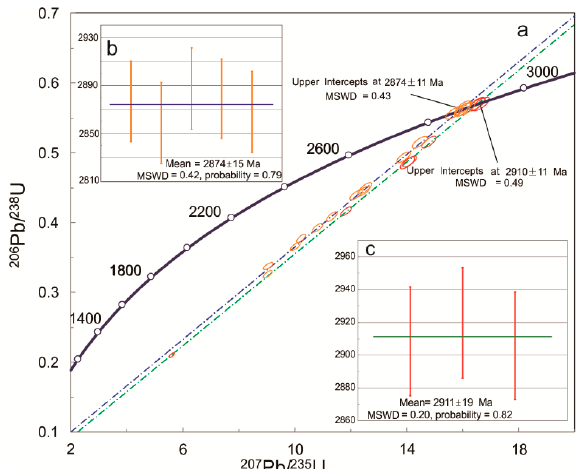
Figure 13. Zircon U–Pb concordia age diagrams for the moyite dike (D0002-5). ( a ) Diagram for all analyzed spots that gave two discordia lines with two upper intercept 207 Pb/ 206 Pb ages of 2910 ± 11 Ma and 2874 ± 11 Ma; ( b ) Diagram for five concordant analyses that gave a weighted mean 207 Pb/ 206 Pb age of 2874 ± 15 Ma; ( c ) Diagram for three concordant analyses that gave a weighted mean 207 Pb/ 206 Pb age of 2911 ± 19 Ma.